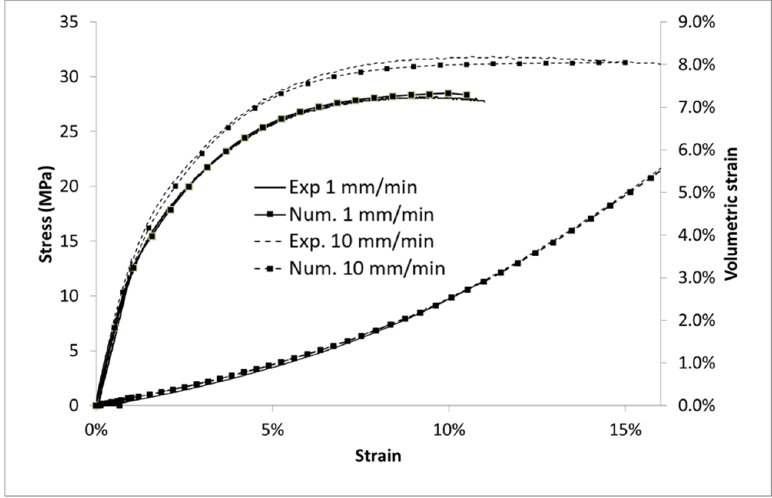
Figure 15. Modelling of PP, stress, and volumetric strain vs. Lagrangian strain.